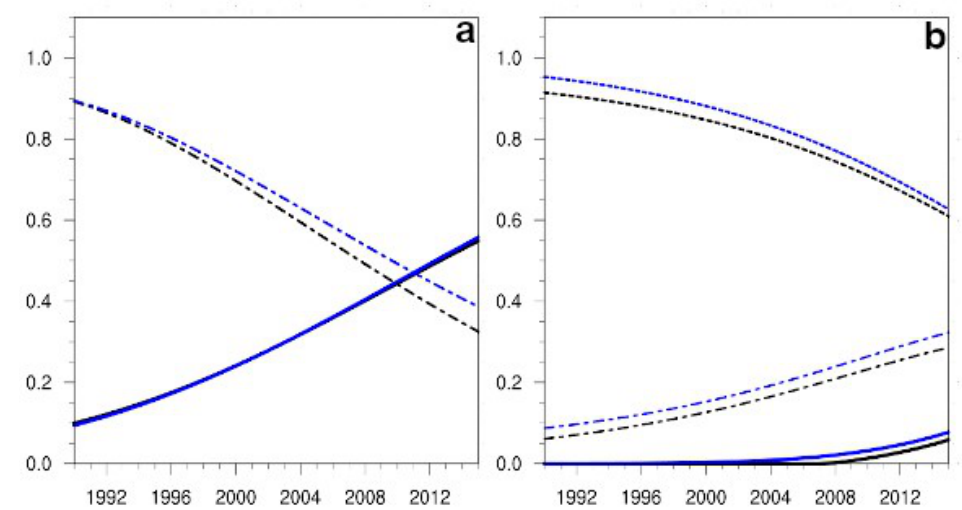
Figure 7. ( a ) Projection in time of the Sobol sensitivity indices, S i and S T and the Intra-European flights (L) case, β values as in Figure 6a. Linestyles and colour codes are the same as in Figure 4b. ( b ) The evolution in time of the Sobol sensitivity indices for the emissions variable for the same flight type and case study, with colour codes and line styles as in ( a